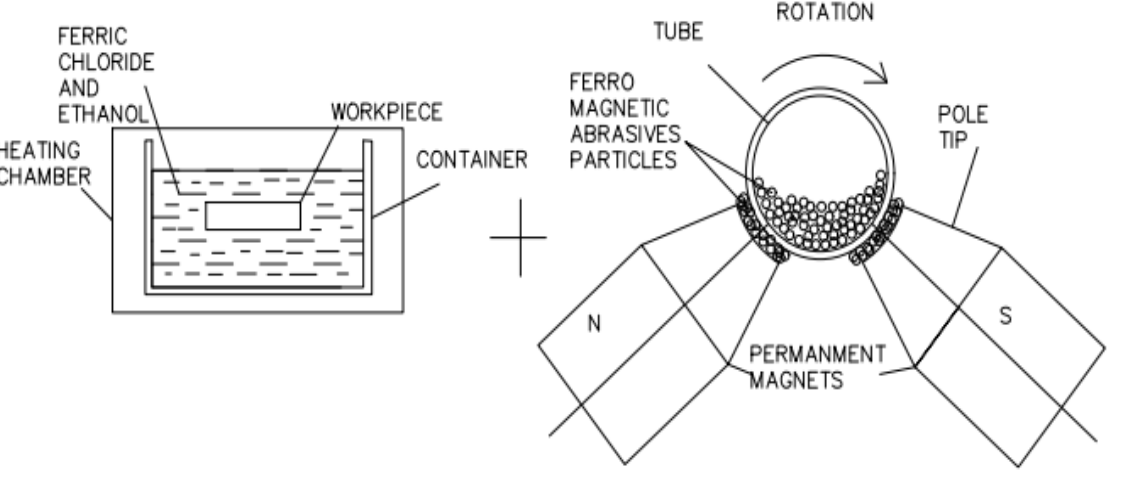
Figure 1. CMAF Principle “Reprinted/adapted with permission from Ref. [15]. Copyright year